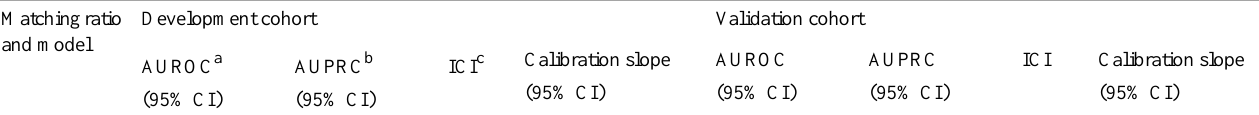
Table 3. Overall predictive performance for each machine learning algorithm with imbalance adjustment in the development and validation